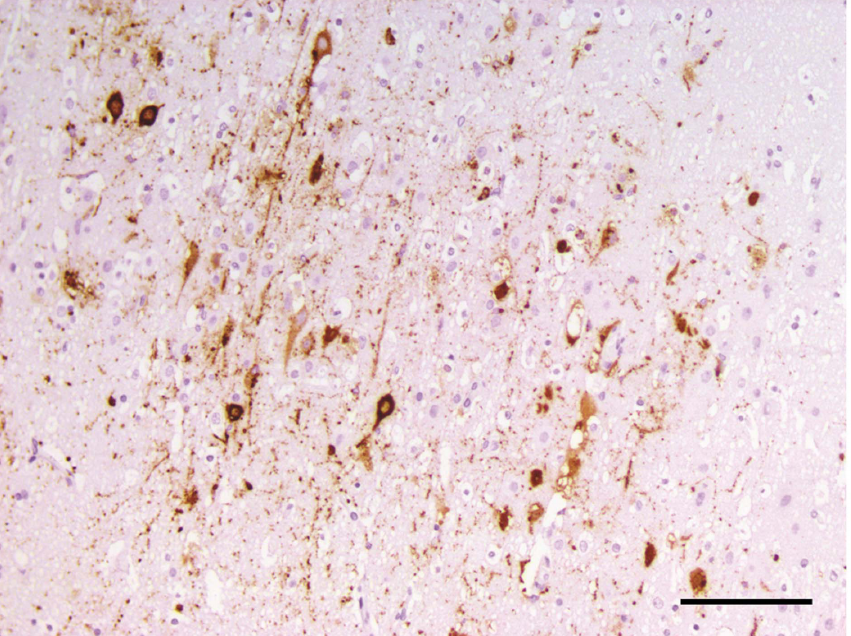
Figure 3. Immunohistochemistry (IHC) for CDV on cerebral cortex tissue of wolf Wa. xNeurons from the cerebral cortex show a strong and specific CDV immuno-reactivity. Scale bar=100 m m.